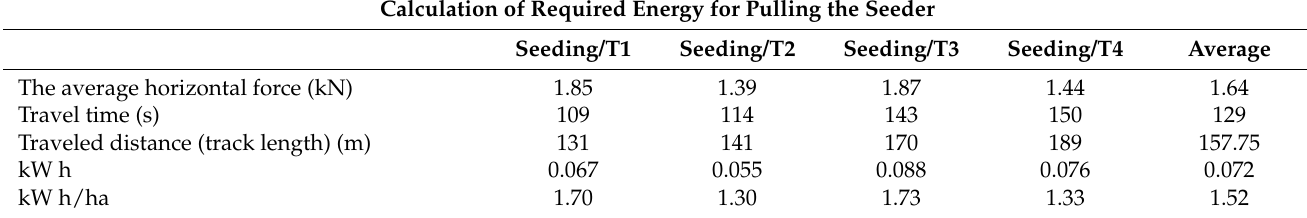
Table 6. Calculation of required energy for pulling the